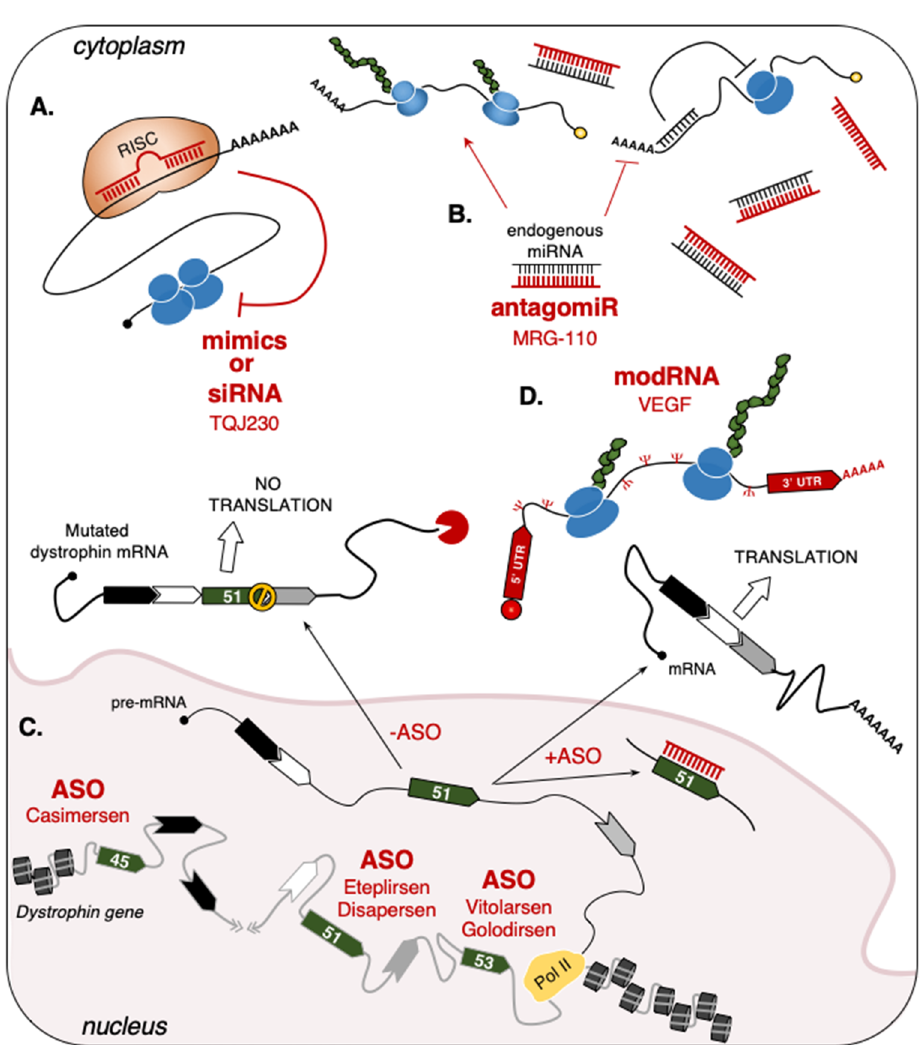
Figure 2. RNA-based drugs in muscular and cardiovascular pathologies. ( A ) “Mimics” and siRNAs act by targeting specific mRNAs to inhibit their translation. Examples include the TQJ230 siRNAs, which specifically recognize and induce the degradation of ApoA mRNA in patients with pre-existing cardiovascular diseases [91]; ( B ) “AntagomiRs” act by sponging endogenous miRNAs, thus preventing their translational repression. MRG-110 was used to block miR-92a activity on pro-angiogenic genes to induce wound healing [92]; ( C ) ASO can be used to modify the splicing of precursor mRNAs (pre-mRNA). The exon-skipping strategy applied to dystrophin exon 51 is shown as an example. In DMD patients (-ASO), genetic mutations lead to the formation of a premature stop codon (STOP symbol) in the mature transcript that causes the lack of protein translation. The use of ASO base-pairing with dystrophin exon 51 (+ASO) promotes its exclusion from the mature mRNA and leads to the translation of a shorter (but functional) protein. For each targeted exon, the ASO approved by the FDA (Food and Drug Administration) are indicated [93–97]; ( D ) VEGF modRNA used in MI patients [98] . The uridine into pseudouridine substitution is represented by the greek Ψ symbol (red). Grey line: DNA; black line: RNA; red line: Therapeutic RNA.